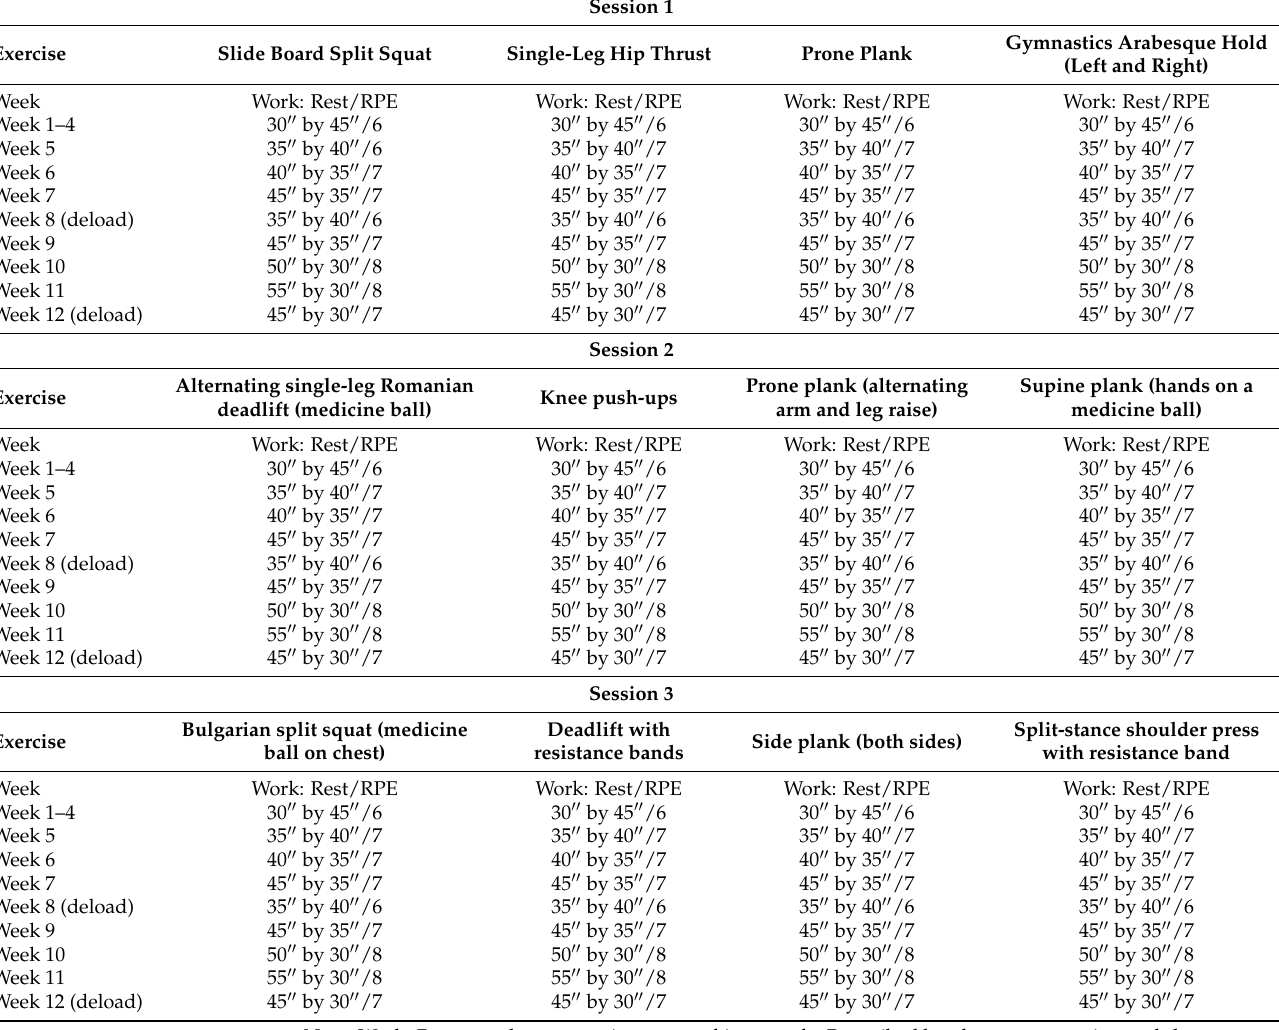
elastic bands and medicine balls as training aids (see Table 1 for more detail). Table 1. Circuit training